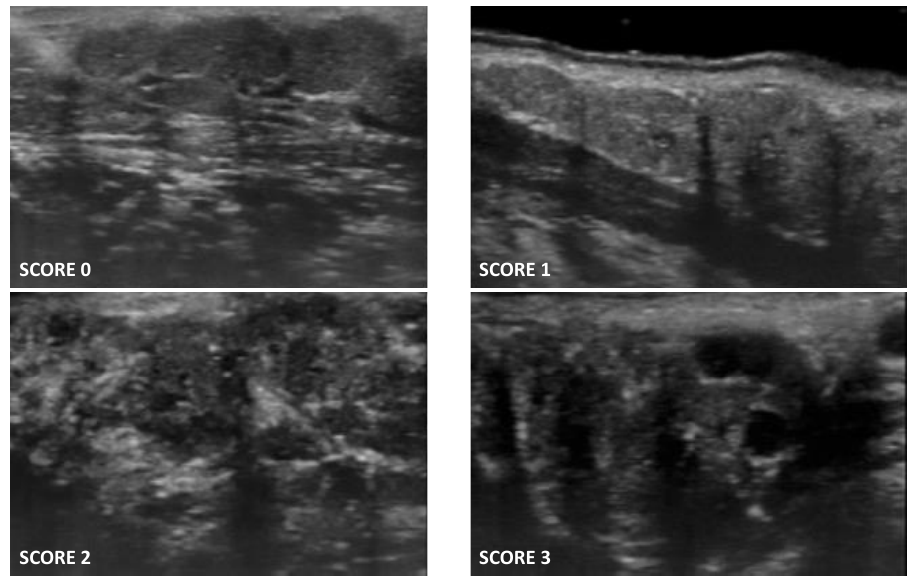
Figure 1. UHFUS scoring system of minor salivary glands.